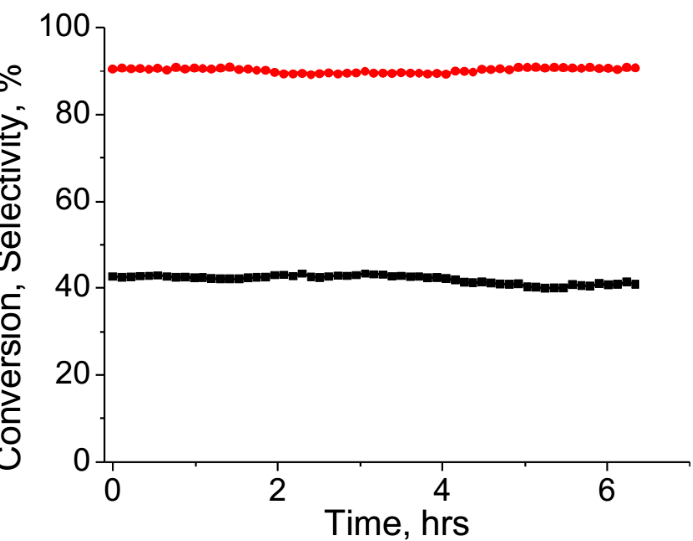
Figure 9. Catalytic performance of Co@NC-Gr SA catalyst versus reaction time at 365 °C: conversion of ethanol ( ■ ) and selectivity to acetaldehyde ( ● ). Feed composition: 5 vol.% EtOH, He balance; GHSV ≈ 18,000 h − 1 .